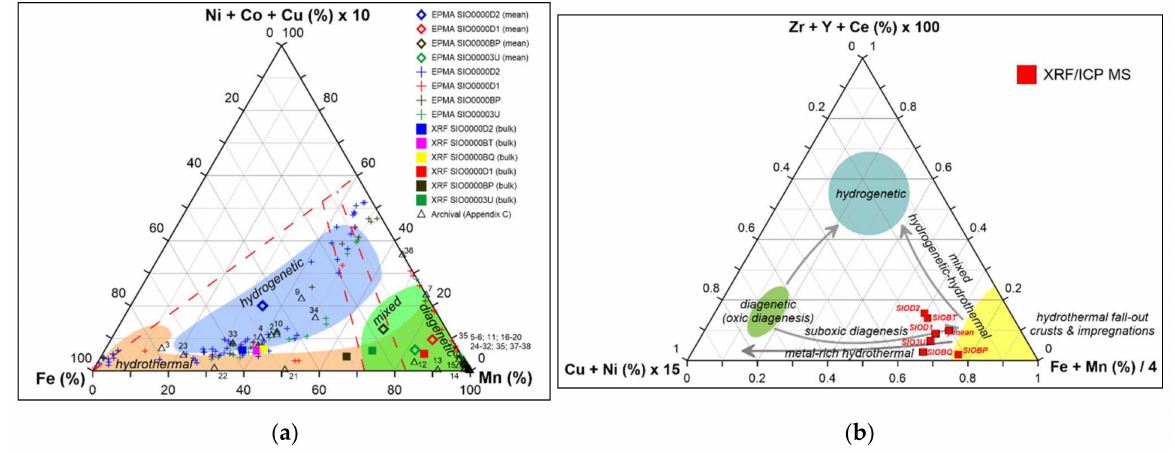
Figure 8. ( a ) Traditional ternary discrimination diagram ([16] with further modifications) of studied crusts. ( b ) Discriminative scheme of analyzed C-N crusts based on comparison of major elements (Mn, Fe), metals (Cu, Ni) and HFSE (after